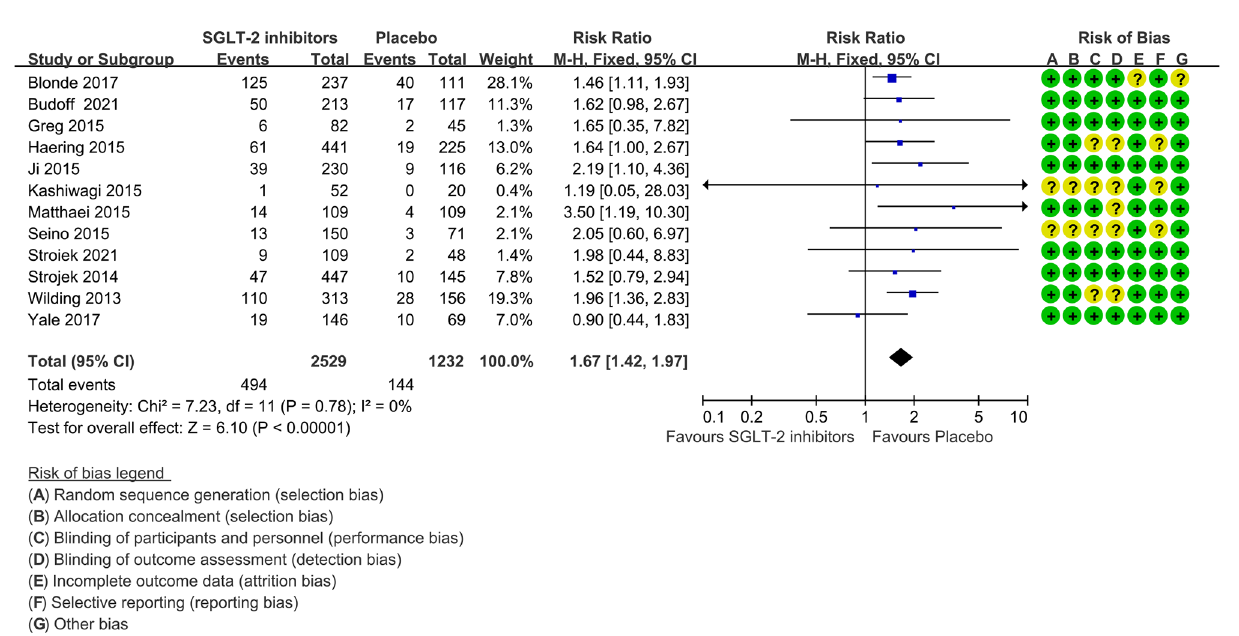
FIGURE 3 | Risk of hypoglycemia in all included trials. Forest plot showing risk of hypoglycemia in patients treated with SGLT-2 inhibitors plus sulfonylureas compared with placebo plus